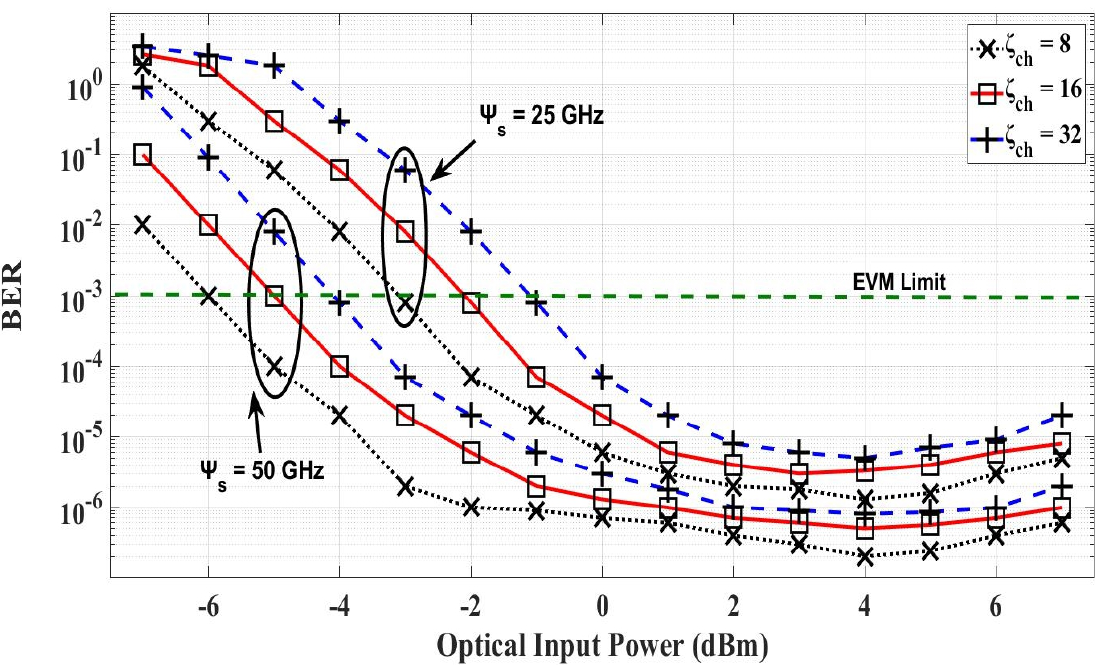
Figure 13. BER for different input power levels for 8, 16 and 32 channels with 25 and 50 GHz channel spacing.